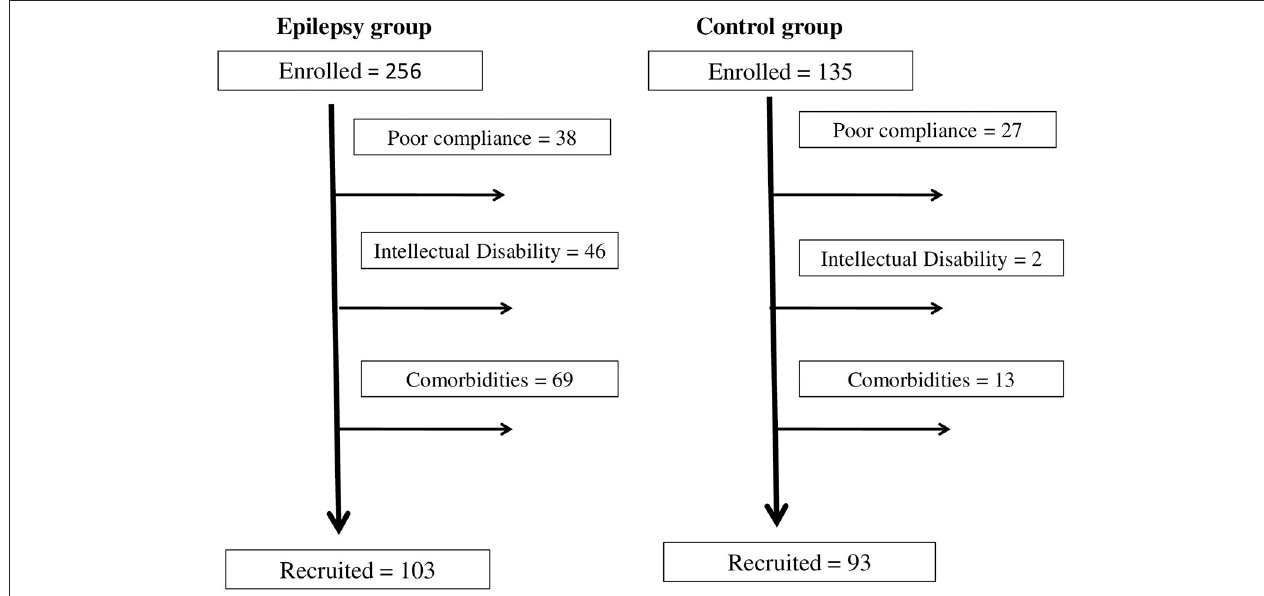
FIGURE 1 | Recruitment